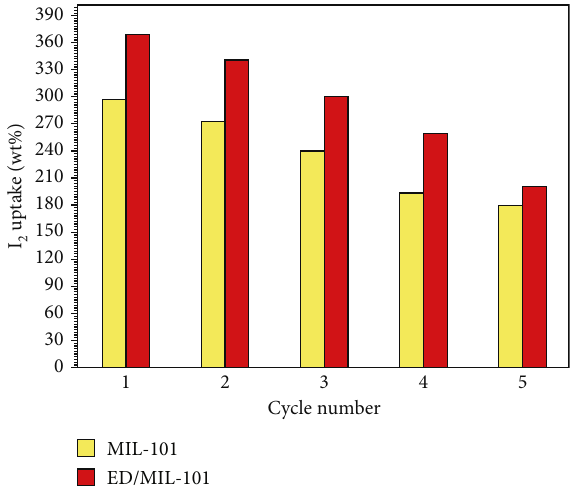
Figure 11: The circulating performance of etched MIL-101 and